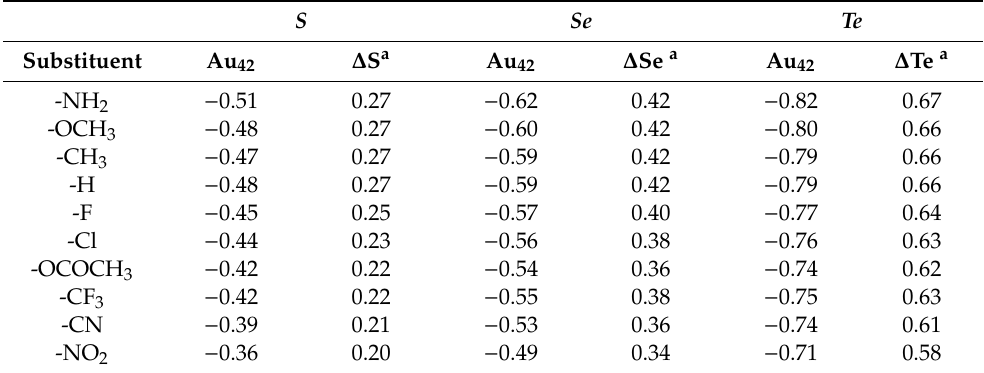
Table 5. Quantification of the charge transfer process between the meta -substituted ligands and the gold-based substrate. These were obtained from the di ff erence between the NPA charges of the complexes and the free